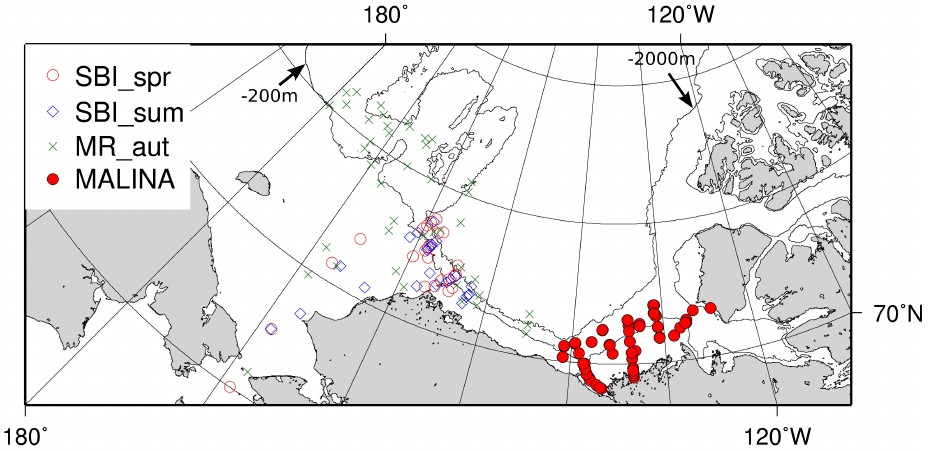
Fig. 1. Locations of sampling stations for the SBI spr (red open circles), SBI sum (blue diamonds), MR aut (green crosses), and MALINA (red closed circles) in the western Arctic Ocean. Note that the SBI spr, SBI sum, and MR aut datasets were used to develop our CDOM absorption algorithm. The MALINA dataset was used to evaluate the performance of the